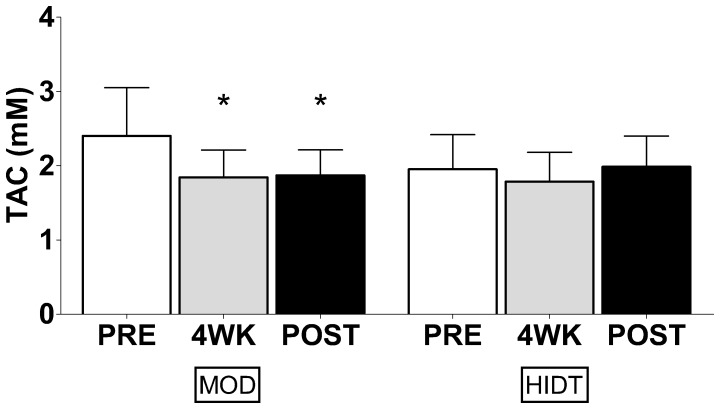
Effect of continuous moderate-intensity training (MOD) and high-intensity discontinuous training (HIDT) on total antioxidant capacity (TAC).White bars represent pre-training (PRE) values, grey bars 4 weeks (4W) of training values and black bars post-training (POST) values. Values are expressed as means ± SD. * Significantly different from PRE (P<0.05).